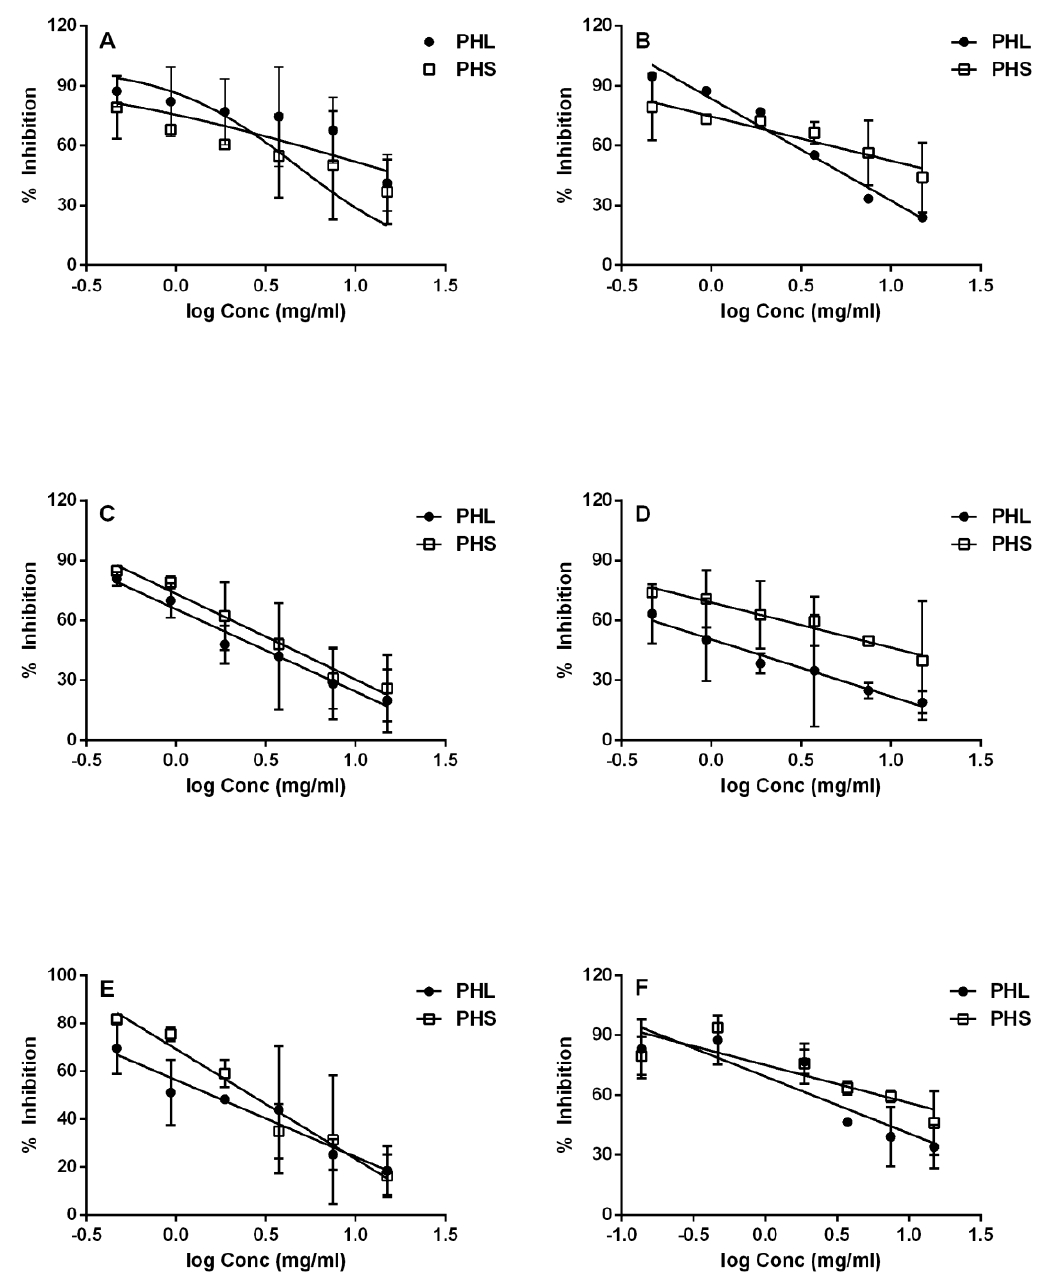
Figure 1. Inhibition of α -amylase activity by di ff erent extracts (ethanol, ( A ); acetone, ( B ); methanol, ( C ); n -hexane, ( D ); chloroform, ( E ) and water, ( F )) of P. hydropiper leaves (PHL) and stem (PHS). Solid lines represent hyperbolic dose–response curves, which were generated in GraphPad Prism. Values represent the means of triplicate measurements (n = 3).